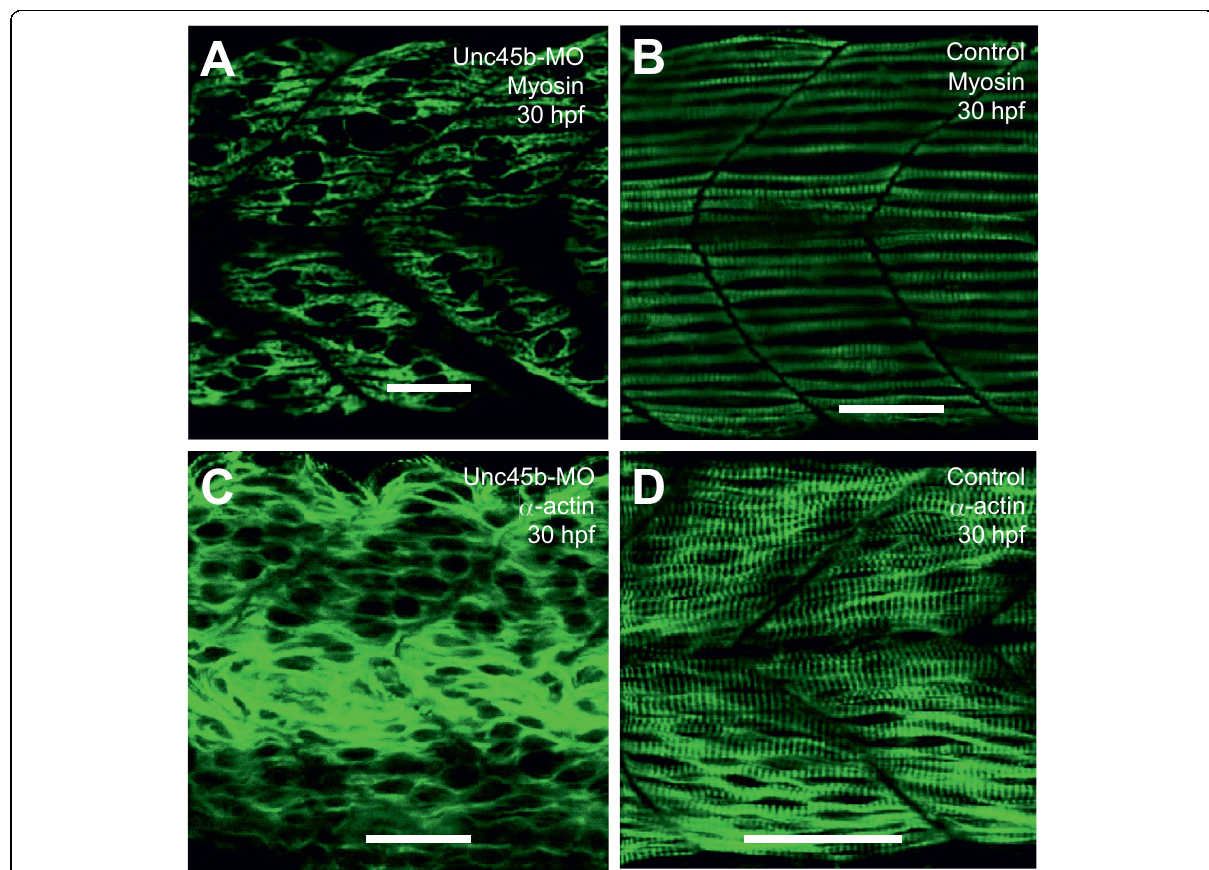
Figure 1 Effects of unc-45b knockdown on thick and thin filament organization in skeletal muscles of zebrafish embryos . A, B . Anti- MyHC antibody (F59) staining shows the organization of thick filaments in trunk slow muscles of uninjected control (B), or unc-45b knockdown (A) embryos at 30 hpf. C, D . Anti- a -actin antibody staining shows the organization of thin filaments in trunk muscles of uninjected control (D) or unc-45b knockdown (C) embryos at 30 hpf. Scale bar = 25 μ m in A, B, C,